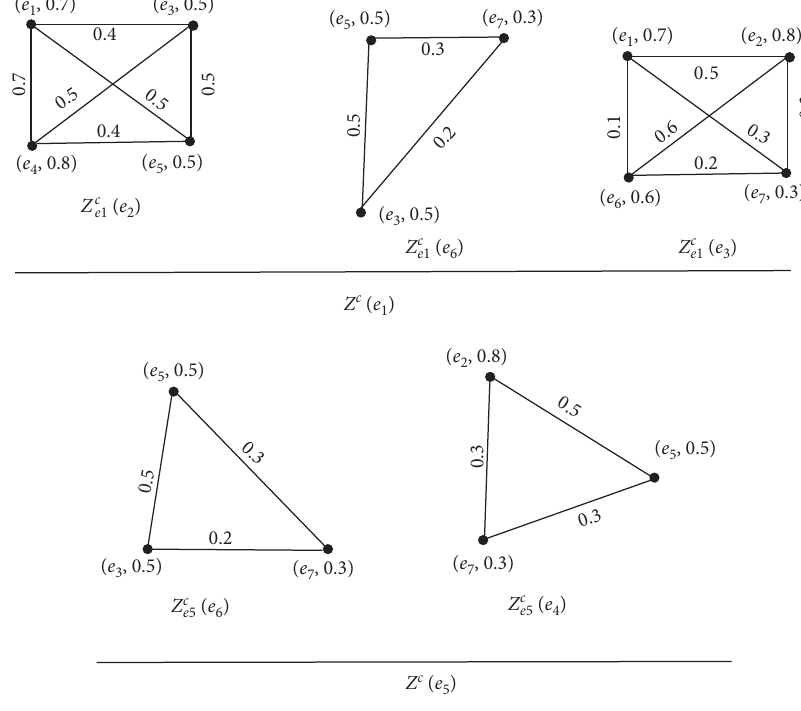
Figure 4: G c � ( Z c ( e